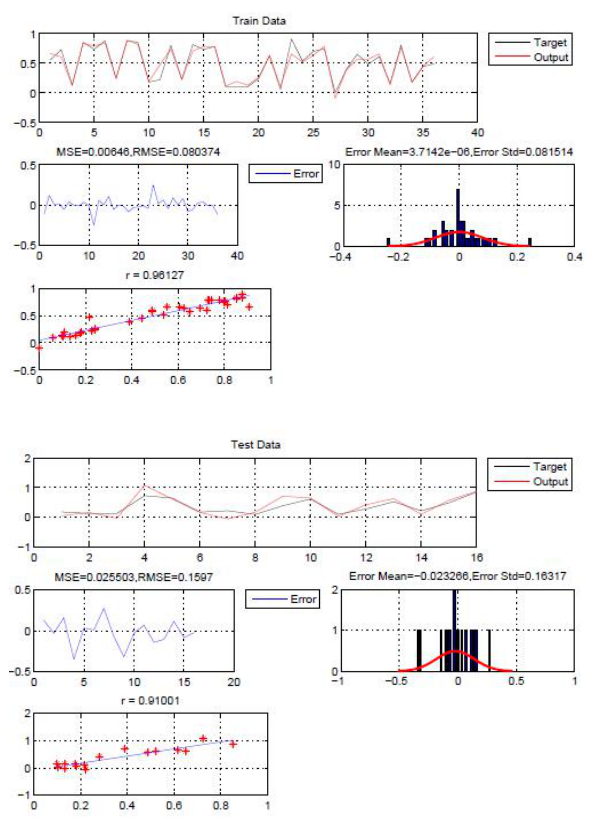
Figure 5. Top : The training results of CPSO-ANFIS. Bottom : The test results of CPSO-ANFIS